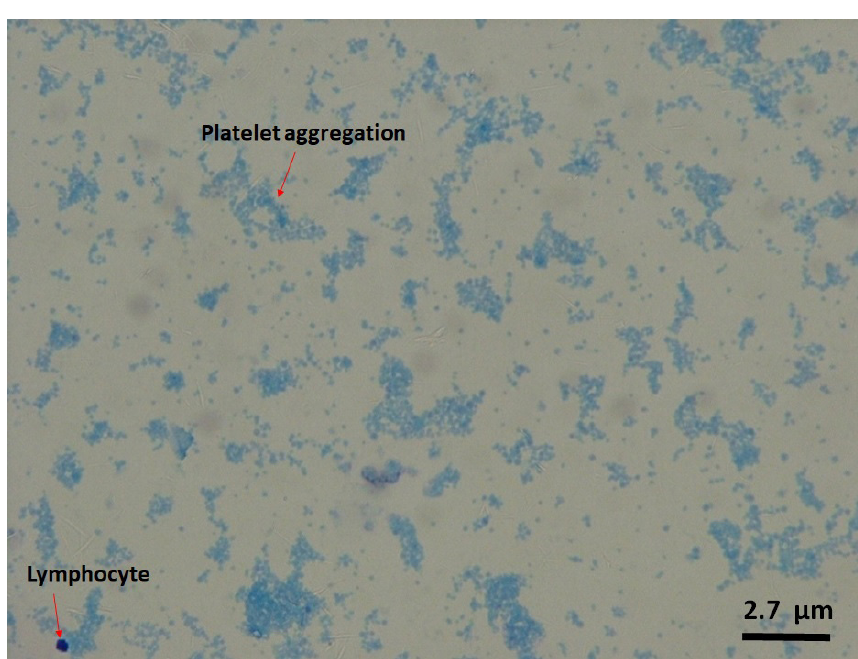
FIGURE 1 - The pathological examination of the final platelet suspension stained by the Wright-Giemsa